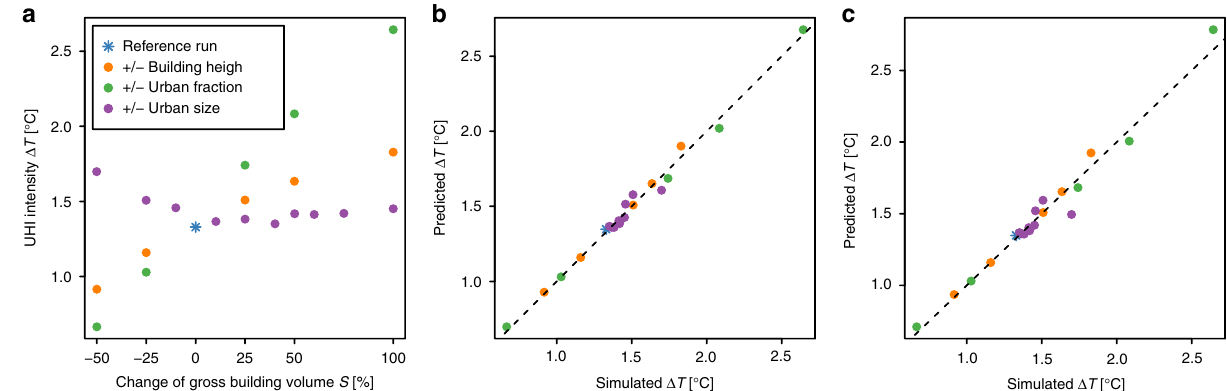
Fig. 4 UHI intensity from urbanisation scenarios of Berlin. a The UHI intensity is plotted against the gross building volume S for corresponding urbanisation scenarios. b The UHI intensity predicted by Eq. (3) is plotted against simulated UHI intensity. c as b but with out-of-sample validation, i.e., the value to be validated is removed from sample and the regression is based on the remaining ones (repeated for each